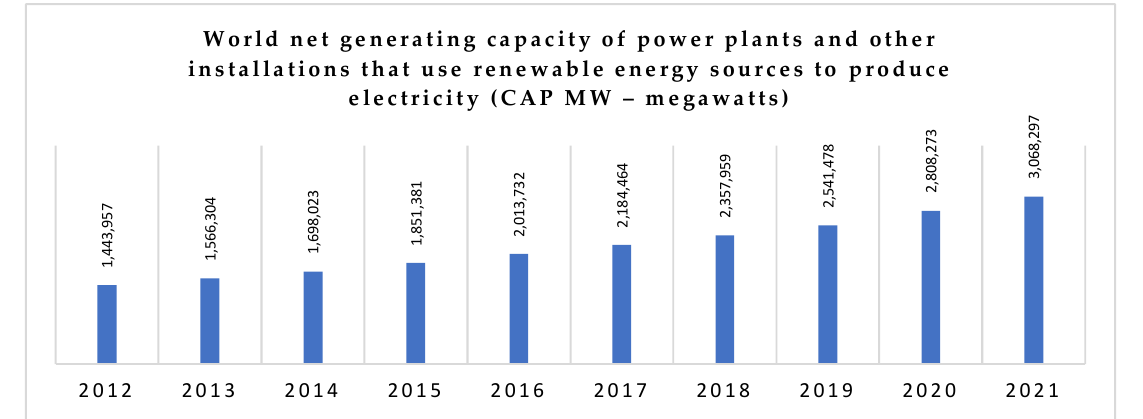
Figure 1. The world net generating capacity of power stations and other facilities that generate electricity using renewable energy sources (CAP), 2012–2021. Source: the authors centralized and adapted data published by ref. [177].